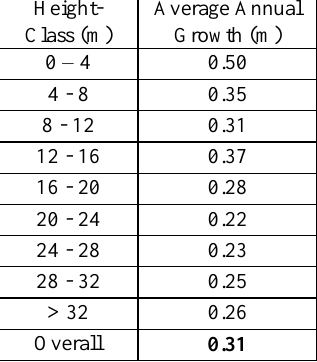
Table 3. Estimated annual individual growth during 2015-2016 Eliminating the top canopy, the sub-canopy could be easily extracted and a sample window from a relatively open stand can be seen in Figure 5. Despite high scan angles in both years, ±40° in 2015 and ±22° in 2016, there is a sufficient penetration through the canopy to capture the growth of the vegetation and subtle foliage changes in the understorey even over a very short period of time.